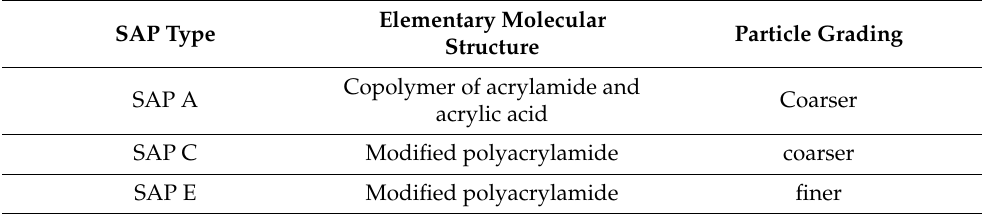
Table 2. General characteristics of studied superabsorbent polymers